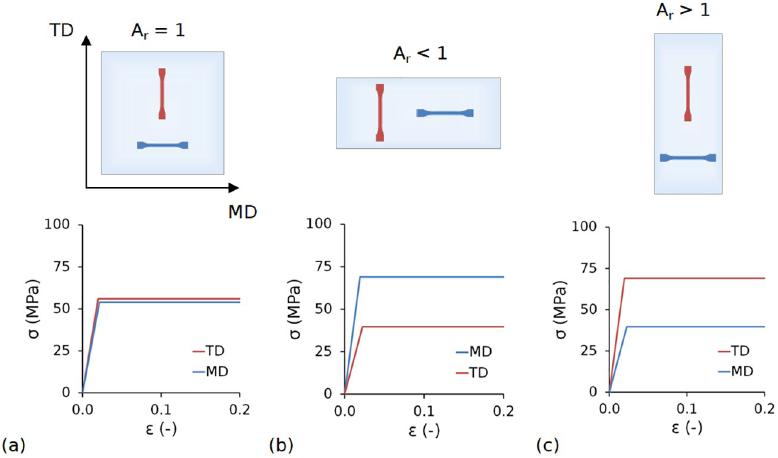
Fig 2. Constitutive model stress-strain ( σ - ε ) curves for (a) A r = 1, which generated a stent design of equal strength and stiffness in both the axial and circumferential directions; (b) A r < 1, which generated a stent design that was stiffer and stronger in the axial direction; and (c) A > 1, which generated a stent design that was stiffer and r stronger in the circumferential direction.